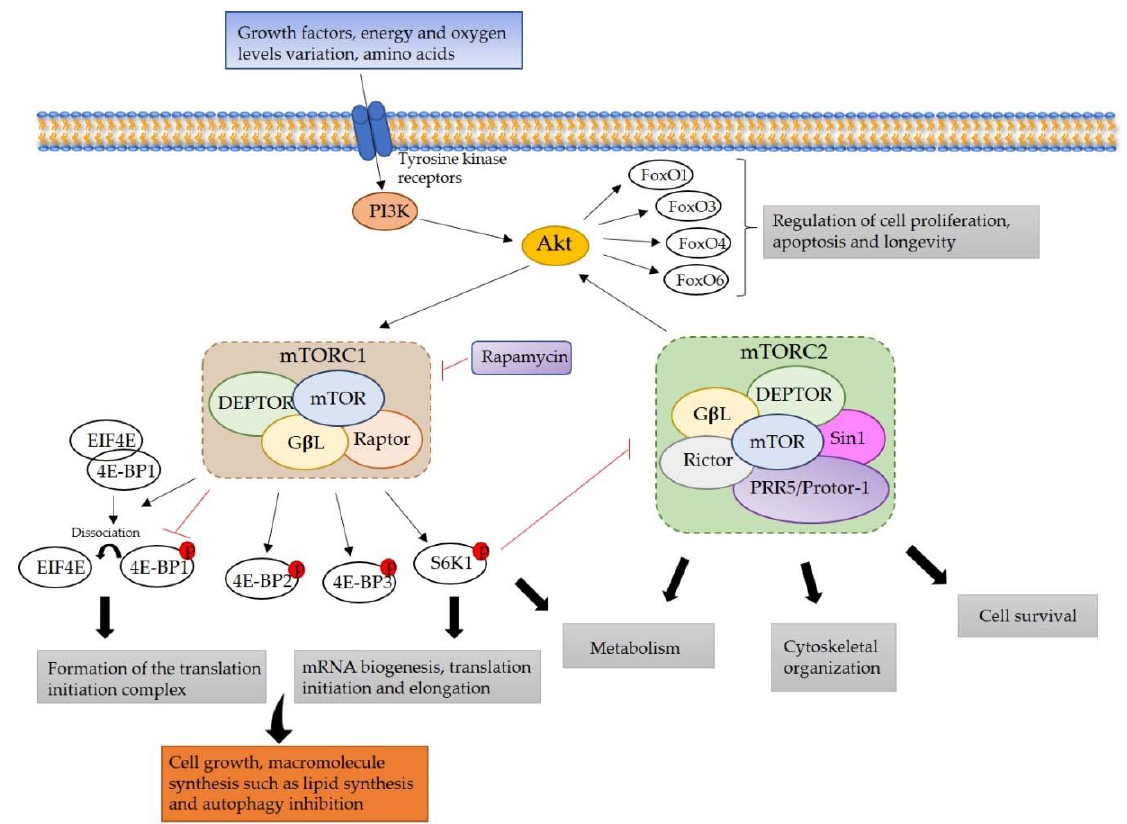
Figure 1. Mechanistic target of rapamycin (mTOR) signaling pathway. mTOR is part of two different complexes, mTOR complex 1 (mTORC1) and complex 2 (mTORC2). mTORC1 is activated by the phosphatidylinositol 3-kinase (PI3K)/AKT signaling pathway, and its downstream effectors activate cell growth, lipid synthesis, and metabolism, whereas it inhibits the autophagy. This complex can be inhibited by rapamycin. mTORC2 activates AKT, thus activating also mTORC1. Furthermore, mTORC2 activates the metabolism, cytoskeletal organization, and cell survival.